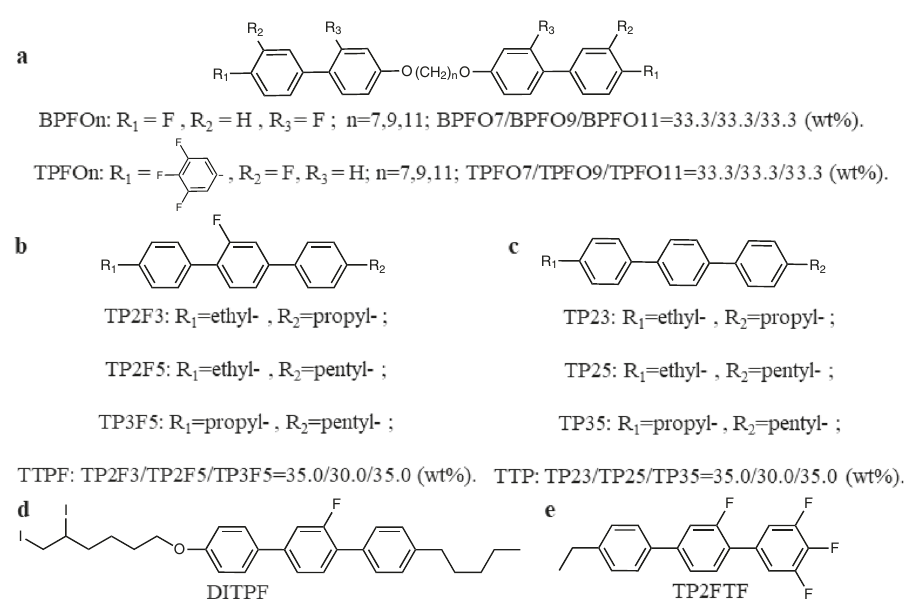
Fig. 1 The molecular structures of the materials. a Mixtures of BPFOn and TPFOn were made from dimeric LCs with fl uoro substituents. b Mixture TTPF from rodlike LCs with a single lateral fl uoro substituent. c Mixture analogs of TTPF without a lateral fl uoro substituent named TTP used for contrast with TTPF. d An analog of TTPF with double iodine substituents named DITPF used for SAXS characterization. e An analog of TTPF with three terminal groups of fl uoro substituents named TP2FTF used to improve the polarity of the materials for better electro-optical performance.